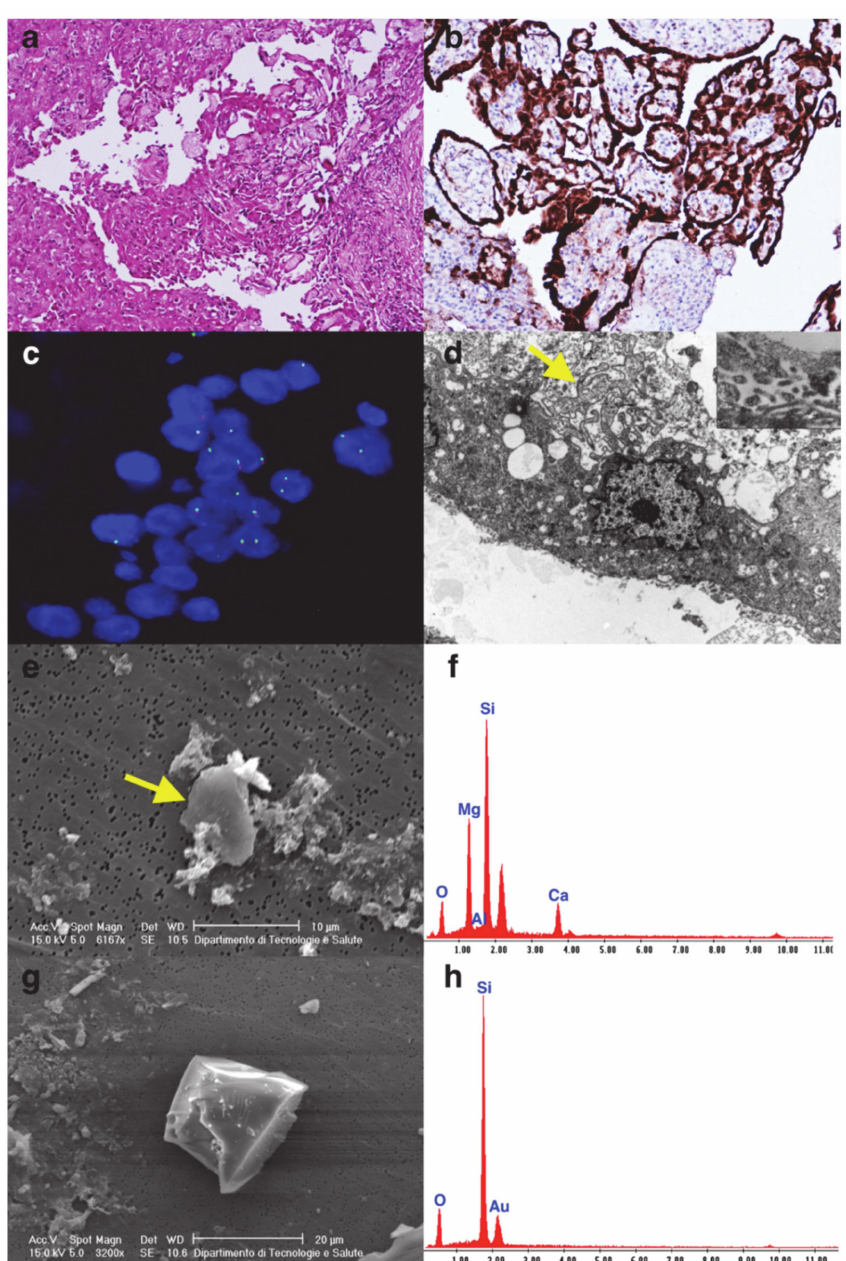
Figure 1. Case 1. Histological section of papillary ovarian mesothelioma (( a ) hematoxylin and eosin stain, original magnification × 200). The neoplastic cells were strongly positive for calretinin (( b ) immunohistochemistry, original magnification × 200). FISH analysis showed CDKN2a (p16) heterozygous deletion ( c ). Upon ultrastructural examination, the neoplastic cells showed microvilli- like expansion (arrow, inset) on the luminal surface (( d ) original magnification × 4400; inset original magnification × 30,000). The SEM micrograph of foliated talc crystals (( e ) arrow) and EDX analysis spectrum of the particle ( f ) were compatible with its general chemical formula (Mg 3 Si 4 O 10 (OH) 2 ). SEM image of quartz crystal and EDX analysis spectrum ( g , h